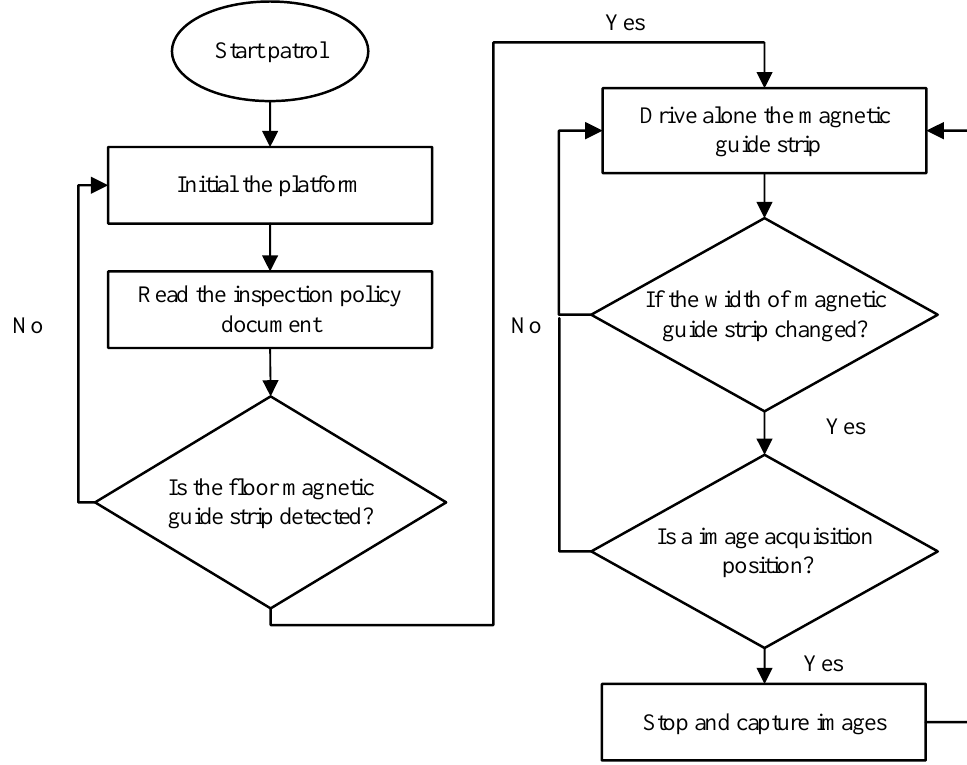
Figure 3. Working flowchart of the autonomous inspection platform.